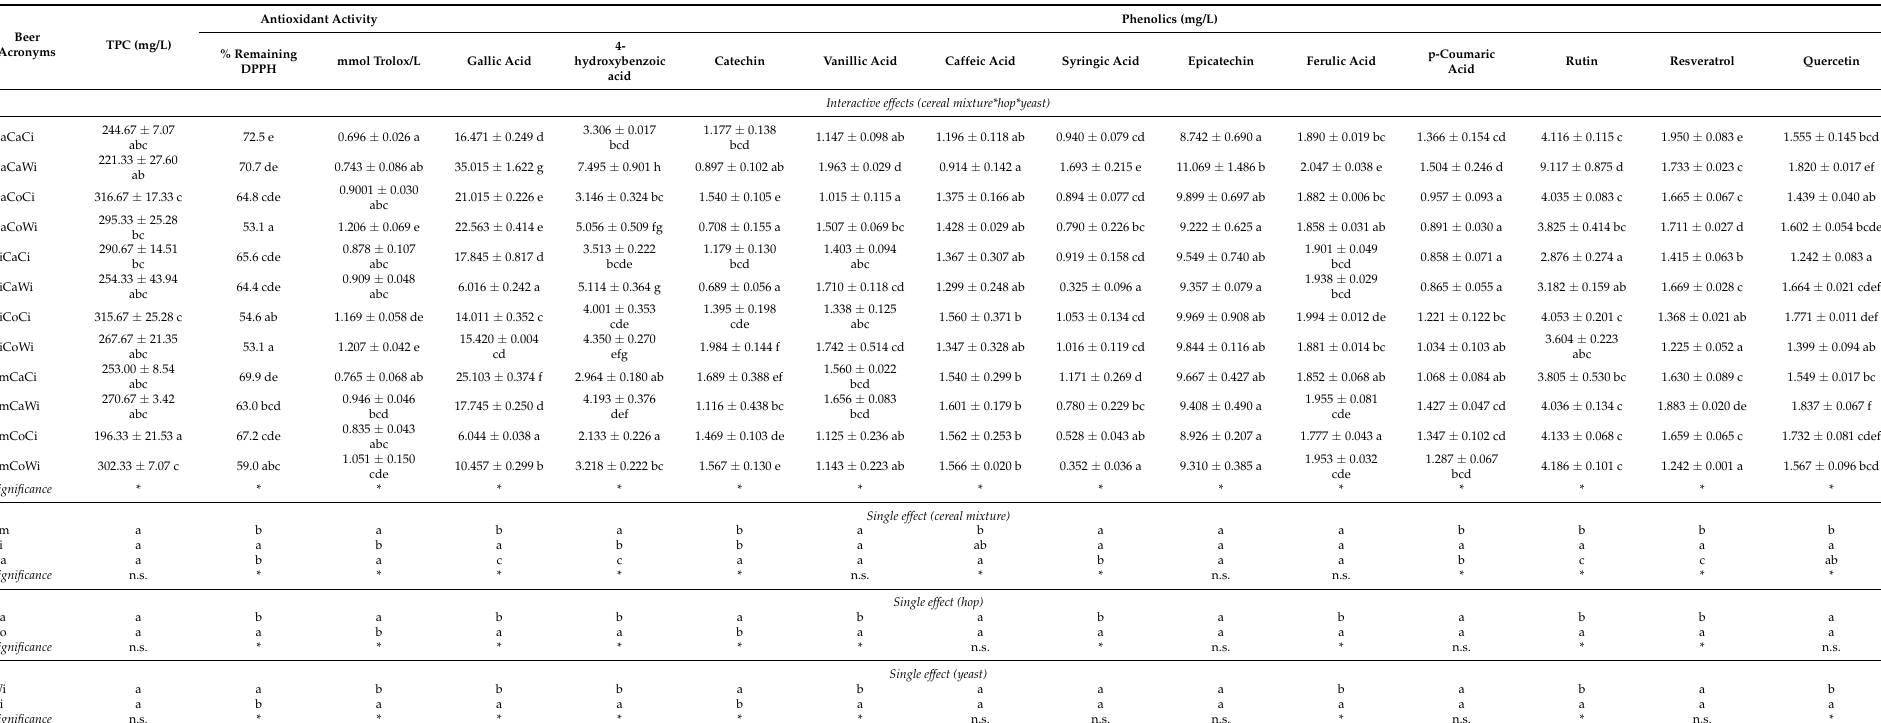
Table 5. Total phenolic content, antioxidant activity, and phenolic profile of beer samples. Single and interactive effects of cereal mixtures, hops, and yeasts used in